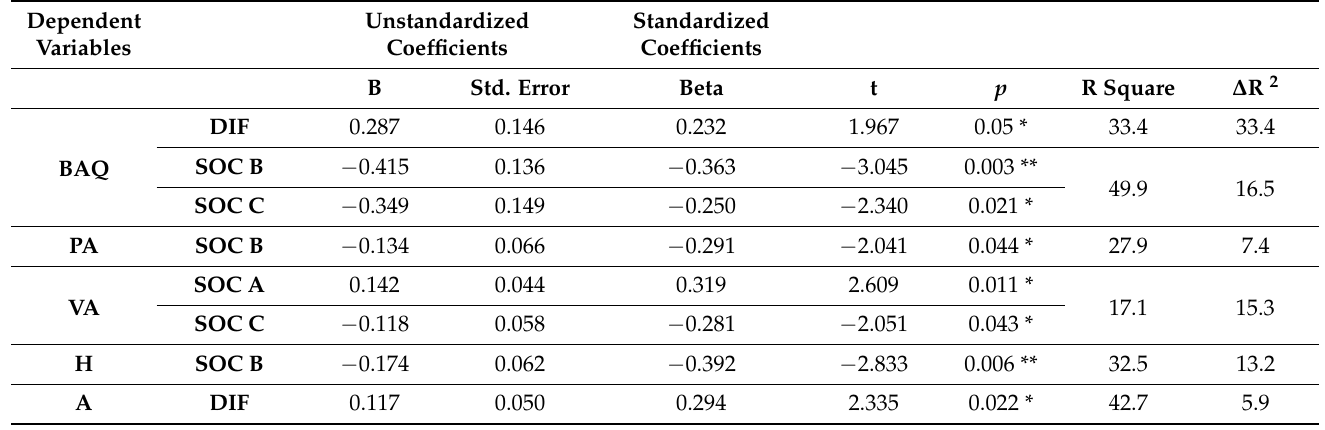
Table 5. Hierarchical regression analyses for variables (TAS and SOC subscales) predicting aggression (BAQ and